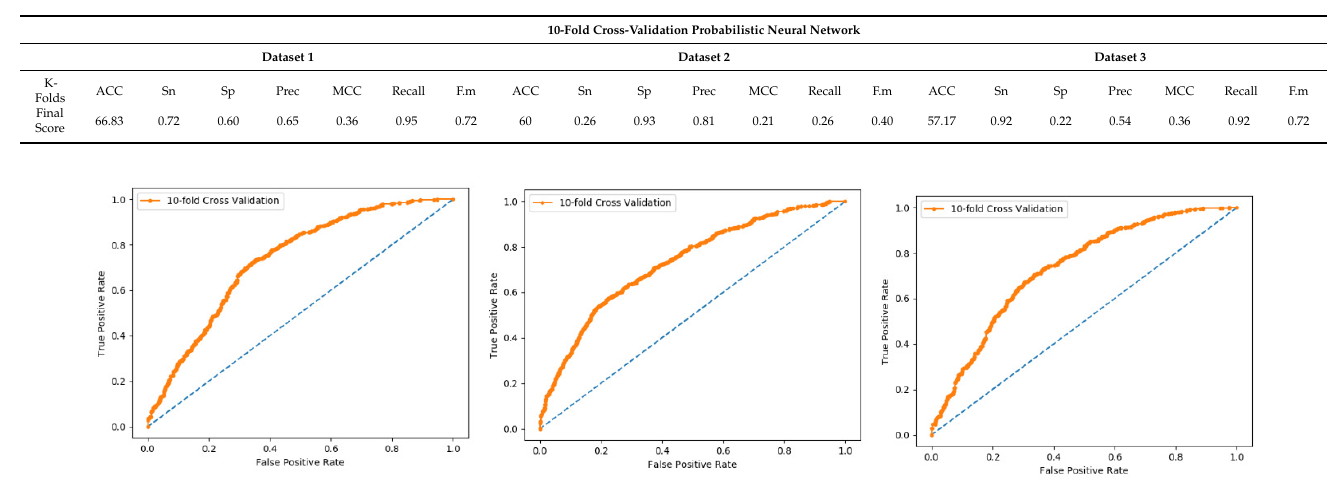
Figure 6. 10-fold Random Forest ROC curve. Table 3. 10-fold cross-validation Result for Probabilistic neural network.